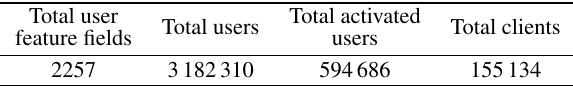
Table 1 Statistics of a private dataset